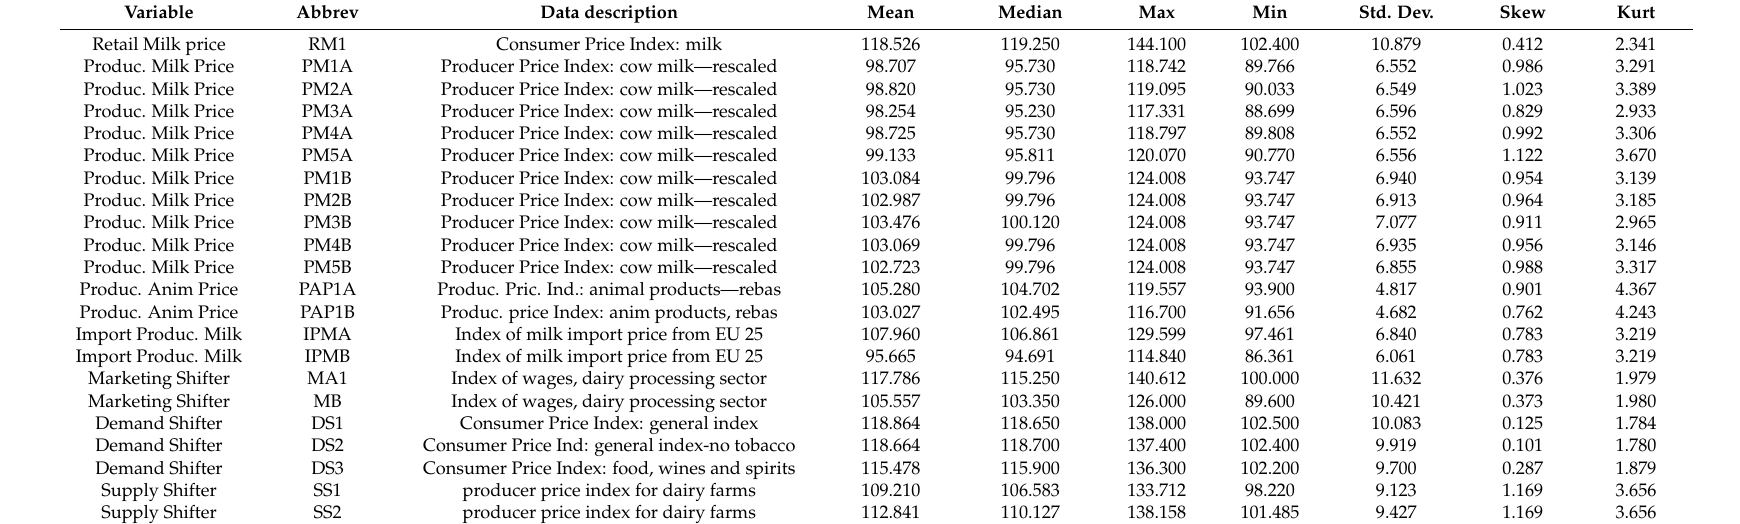
Table A3. Variables included in Dataset AB and descriptive statistics (common sample January 1996–October 2008, 154